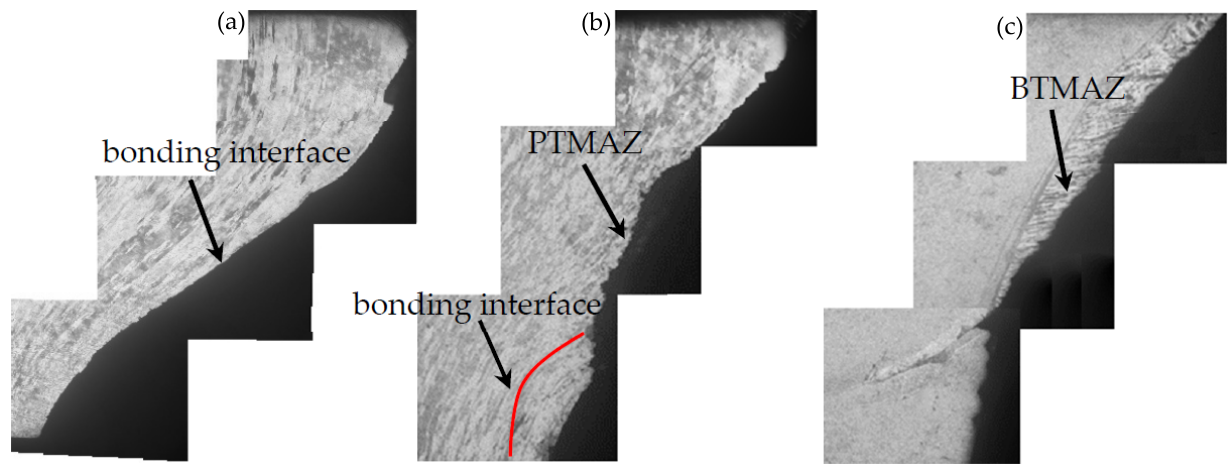
Figure 9. Fracture positions: ( a ) D1 joint, ( b ) D3 joint and ( c ) D4 joint.